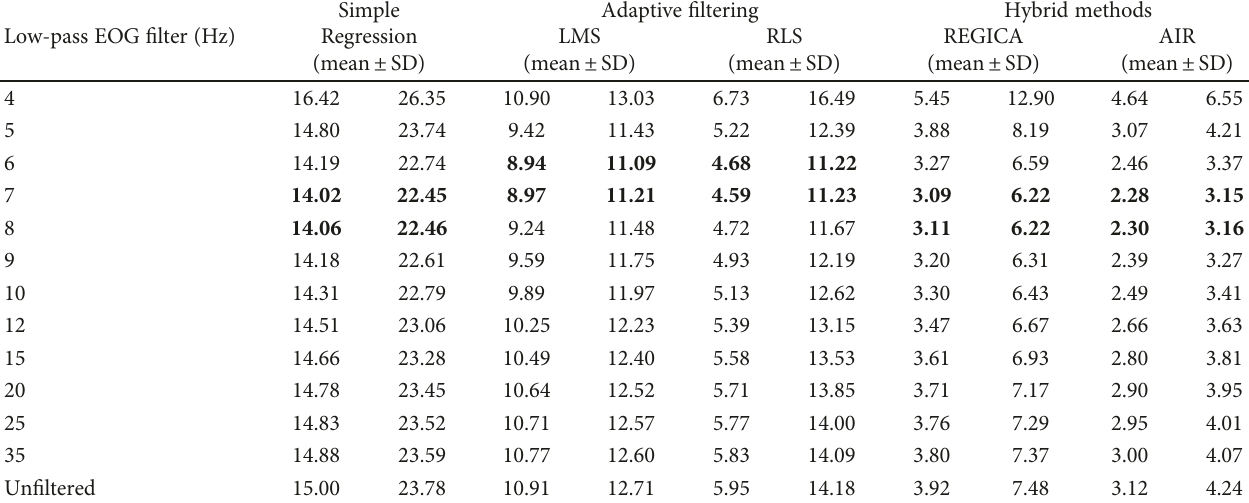
Table 3: Mean square error values (mean of all EEG channels and mean of all simulated